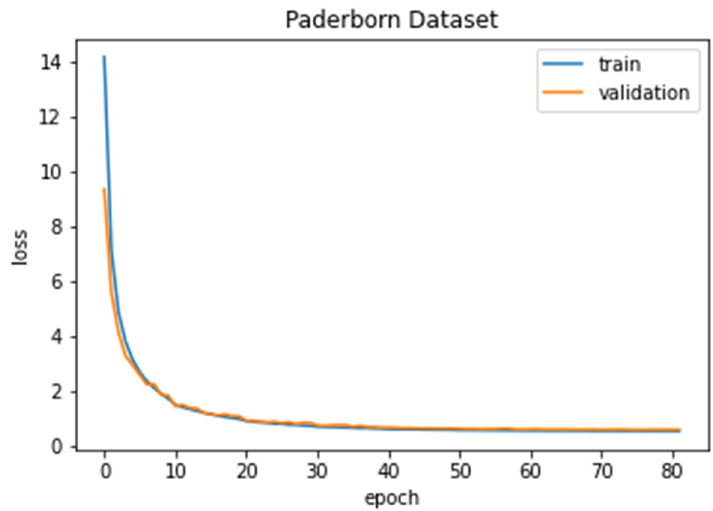
Figure 7. Loss-epoch graph of the proposed method on the Paderborn dataset.